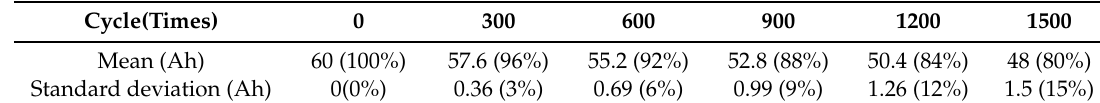
Table 1. Mean and standard deviation in different stages.